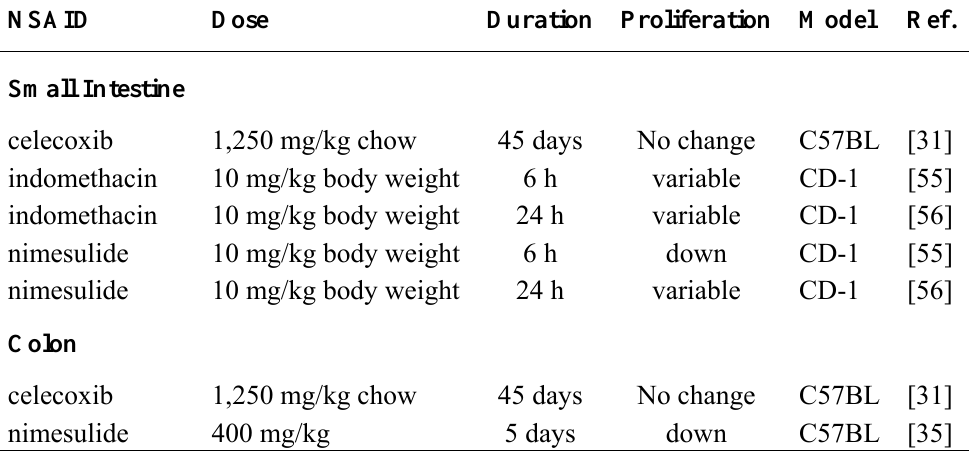
Table 3. NSAIDs and enteric cell proliferation in vivo . The duration of treatment is